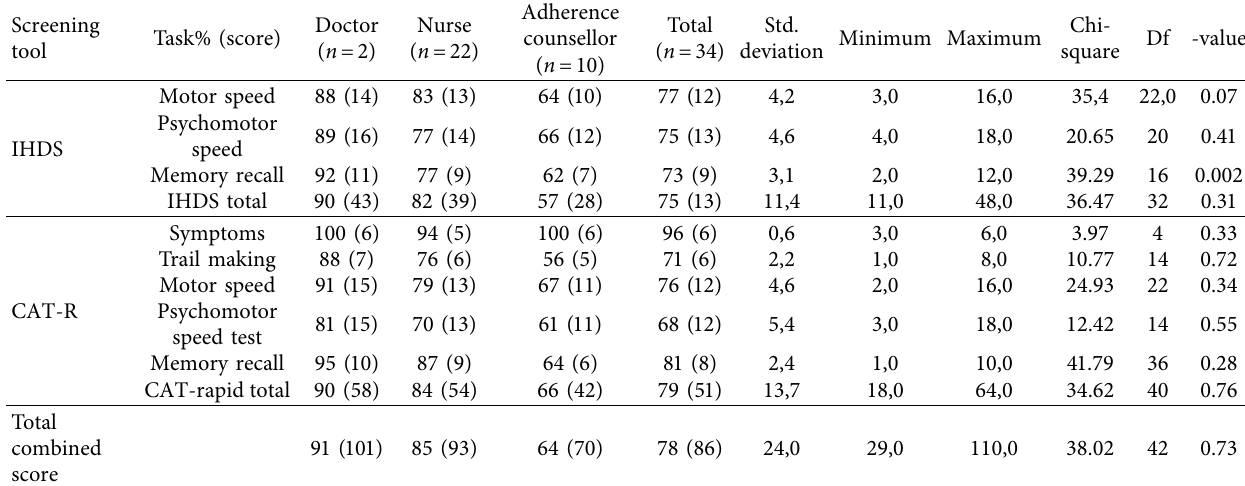
Table 1: Accuracy of healthcare workers’ HIV-associated neurocognitive impairment screening tool delivery.